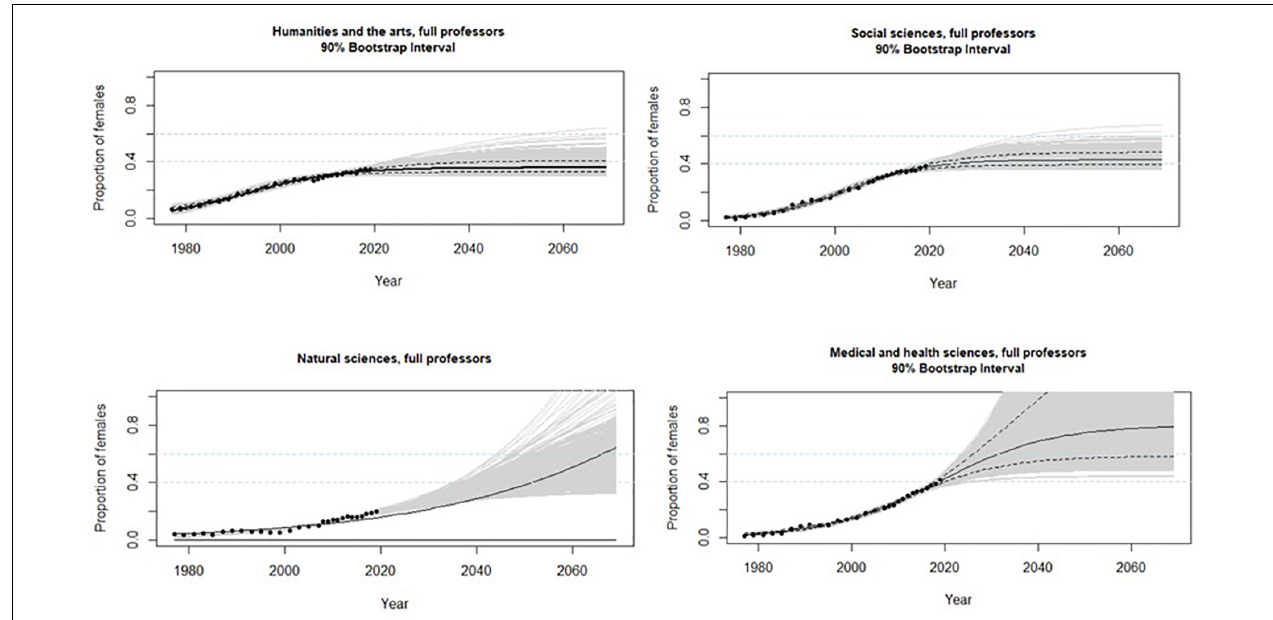
FIGURE 4 | Observed percentages of female professors are black dots. Fit of data to a three parameter logistic model to the observed data is displayed as a black, thin line, extrapolated to the right of the observation span (to 2069). Light gray thin lines are the estimated sigmoid curves based on each of 10,000 bootstrapped time series. The corresponding median is the solid black line. Within the observation span, the bootstrap median estimate is very close to the fitted model based on the observations. Also, 90% quantiles for the bootstrap sigmoid estimates are displayed as dotted lines. Stippled, blue lines give the interval of gender balance (0.40, 0.60). For Engineering and technology and Natural sciences, no parameters could be